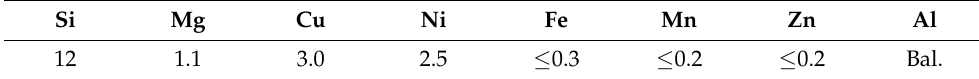
Figure 1. Schematic illustration of the apparatus. Table 1. Chemical composition of the Al-Si-Mg-Cu-Ni alloy [wt%]. Table 1. Chemical composition of the Al-Si-Mg-Cu-Ni alloy